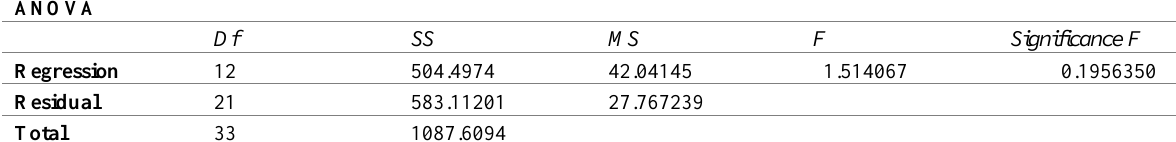
Table 17: ANOVA (Mymensingh Division)